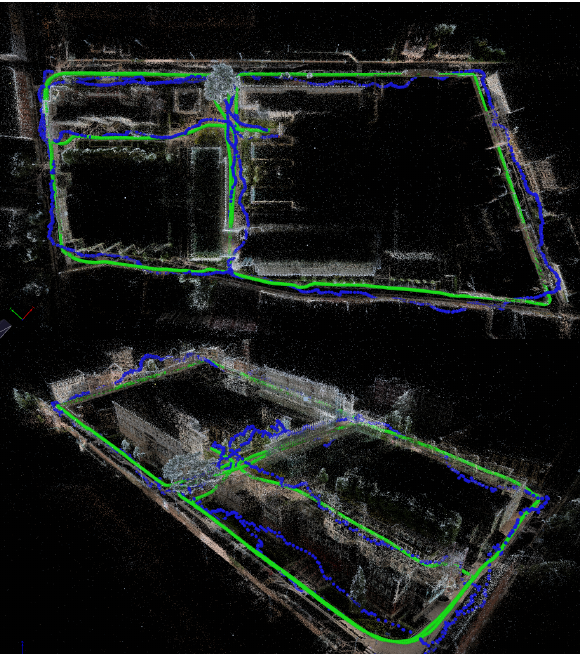
Figure 9: Orientation results obtained with